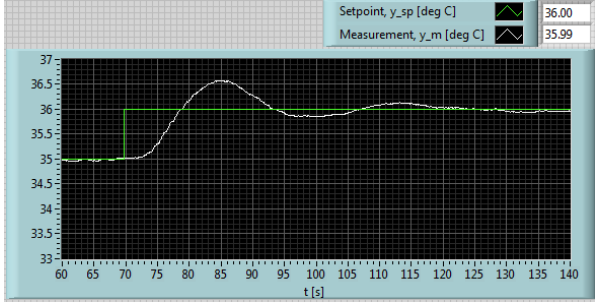
Table 1: Temperature control system: Controller set- tings and performance and robustness mea- sures with Good Gain (GG) tuning and Ziegler-Nichols (ZN) tuning.